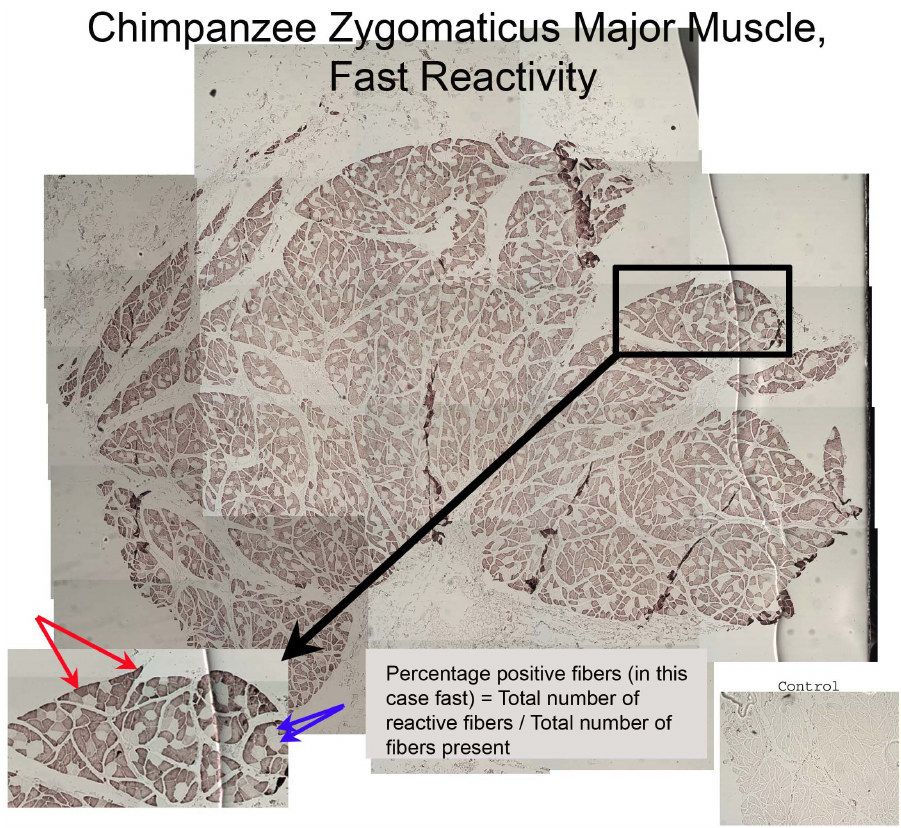
Figure 1. Methodology for calculating percentage of reactive fibers. This is a cross-section through the zygomaticus major muscle of one chimpanzee specimen that was stained for fast-myosin reactivity. Percentages of reactive fibers were determined by counting all of the reactive fibers in each composite image (here, the reactive fibers are stained brown) then dividing that count by the total number of fibers present in the composite image. Blue arrows are pointing to examples of fibers showing positive reactivity for fast-myosin staining; red arrows are pointing to examples of fibers that were non-reactive.